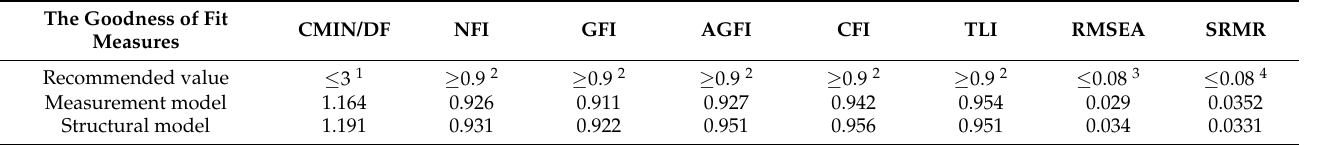
Table 4. Model fit